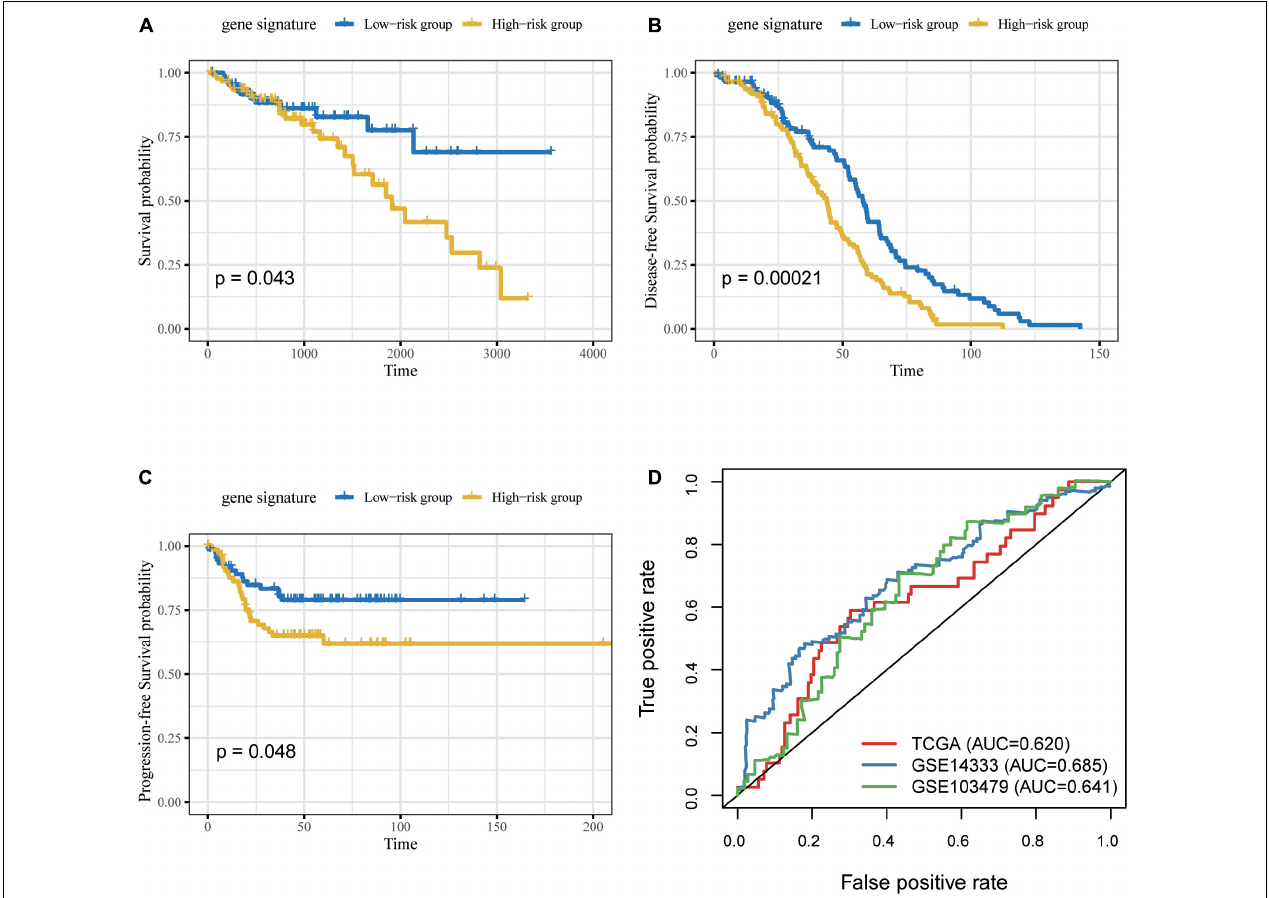
FIGURE 8 | Prognosis of patients with CRC was predicted using the gene signature. Based on Kaplan–Meier survival curves, patients with CRC were classified into high- and low-risk groups using gene expression as signature in the (A) TCGA, (B) GSE14333 and (C) GSE103479 datasets. P -values were calculated via log-rank test. (D) Comparison of the sensitivity and specificity for the prediction of overall survival based on the gene-based CG Score. CRC, colorectal cancer; AUC, area under the